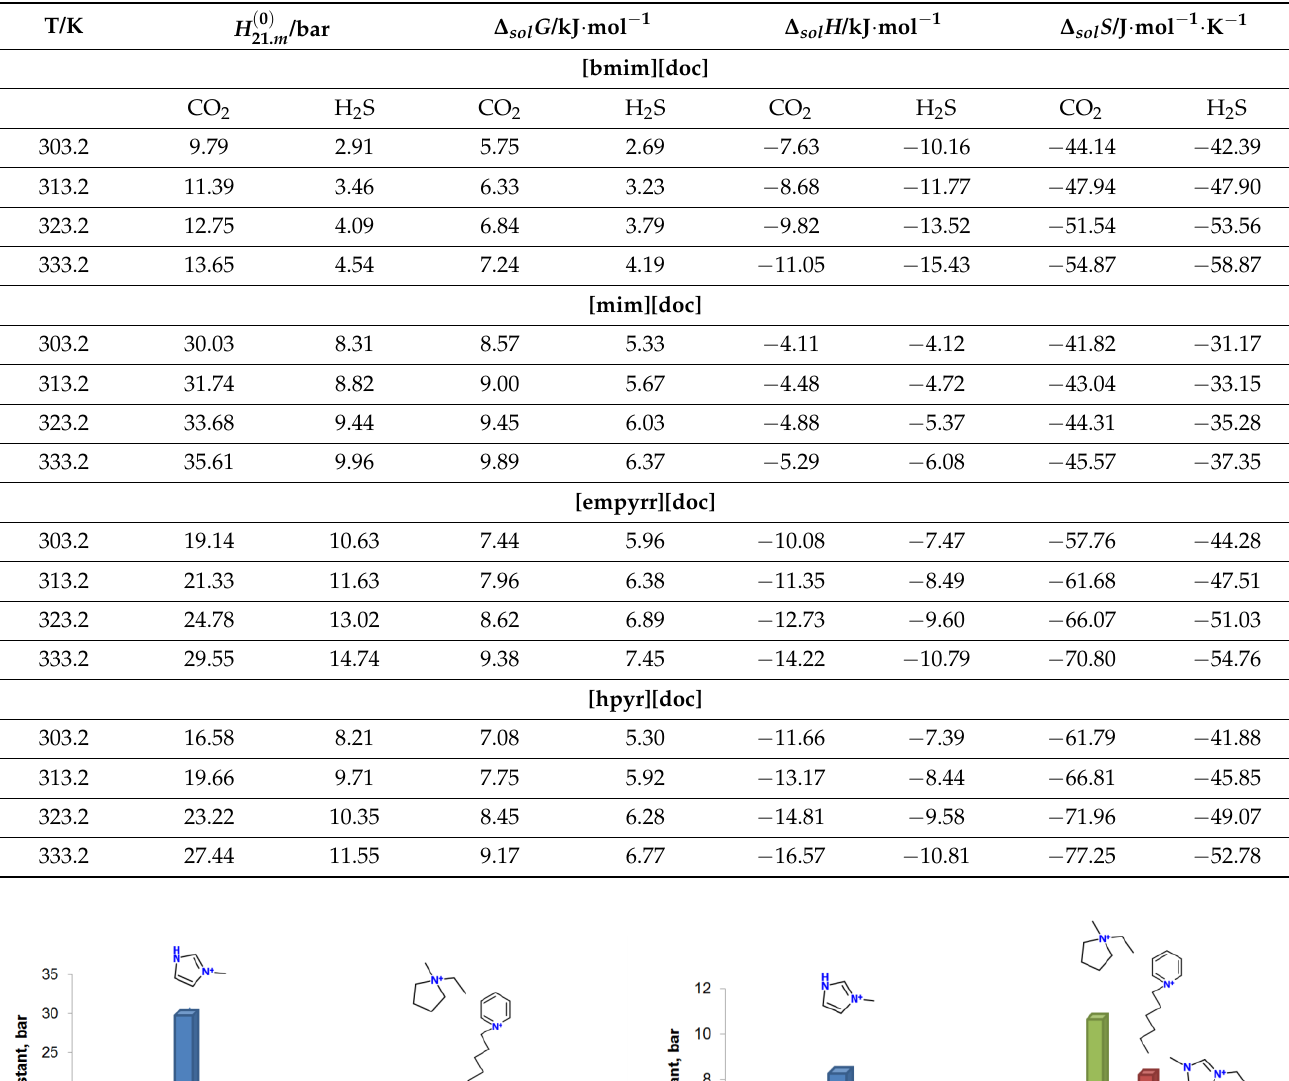
Table 5. The CO 2 and H 2 S Henry’s law constant s.